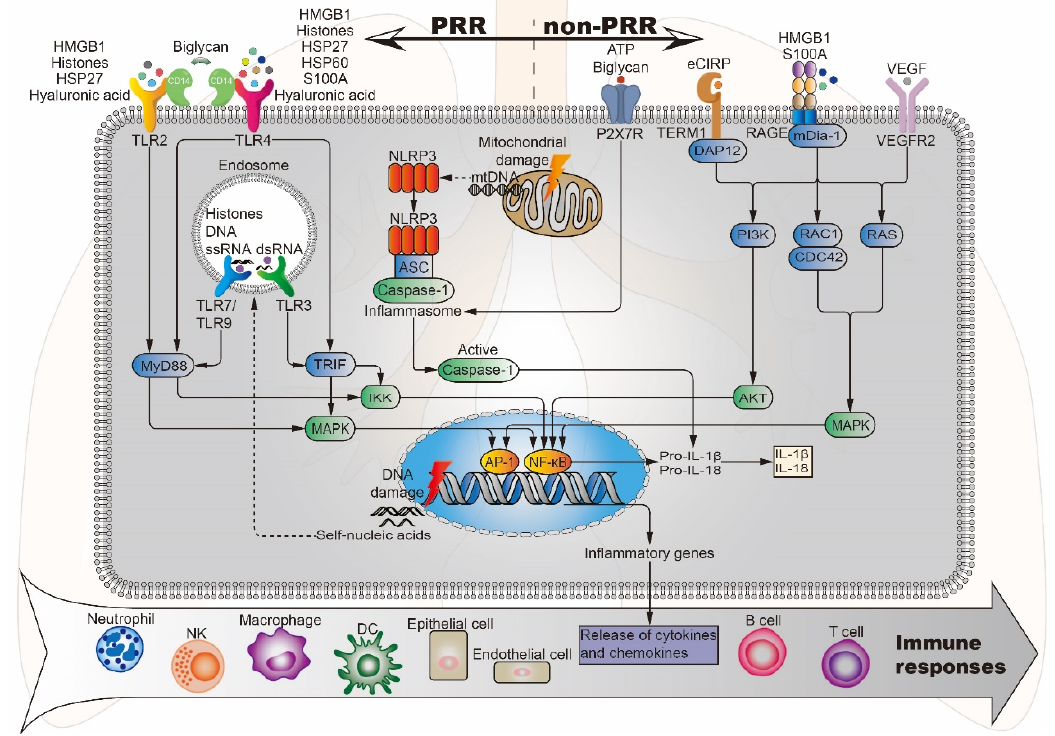
Figure 3. Potential DAMPs and related signaling pathways in BLI. Lung injury-related DAMPs can activate PRR (TLR2/3/4/7/9, NLRP3) and non-PRR (P2X7R, RAGE, TERM1, VEGFR2) to activate the corresponding signaling pathways, induce the release of cytokines and chemokines, and further stimulate effector cells to produce an immune response. DAP12, DNAX activation protein 12; mDia-1, mammalian diaphanous-related formin 1; ASC, apoptosis-associated speck-like protein.